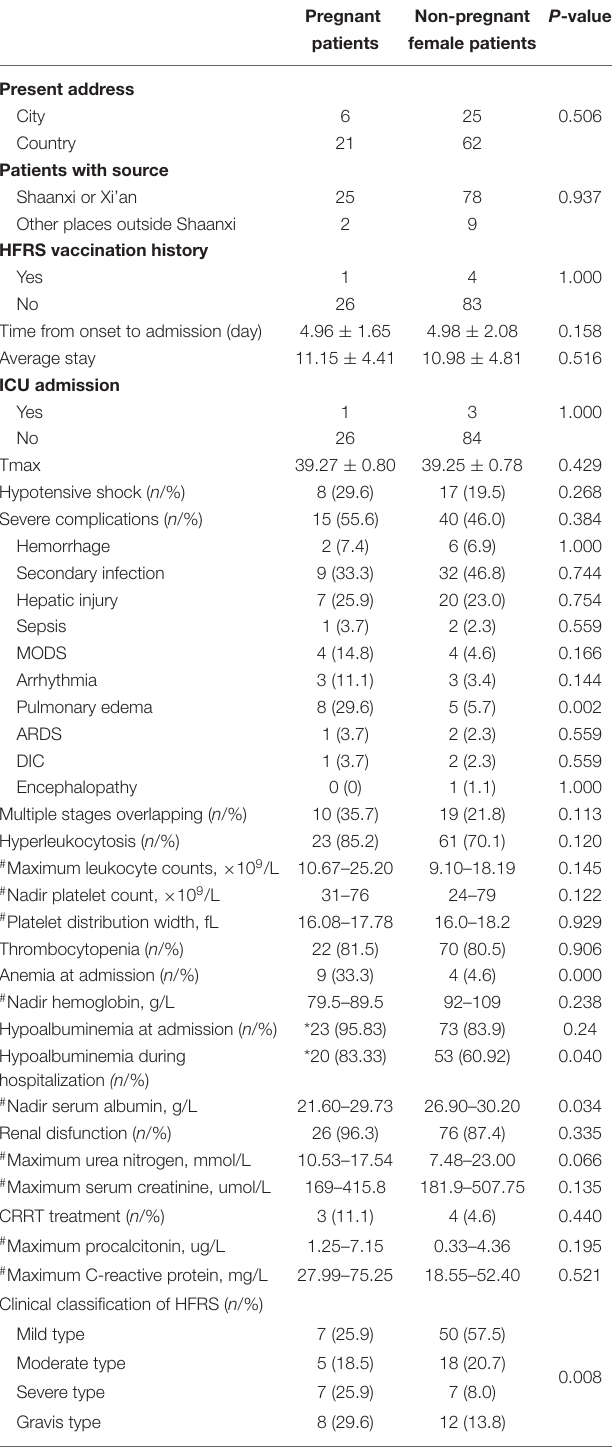
TABLE 4 | Risk factors associated with pregnant female patients with critical TABLE 3 | Comparison between pregnant women and non-pregnant female HFRS. patients with HFRS. Variables Univariable logistic regression Pregnant Non-pregnant P -value patients female patients